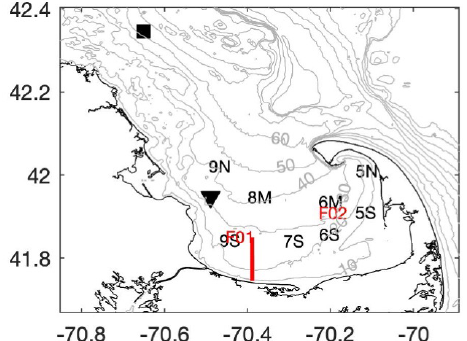
Figure 1. Map of Cape Cod Bay (CCB) showing the locations of the CCS monthly water quality stations (black letters), the MWRA sampling locations in CCB (red letters), NDBC buoy 44013 (black square), MDMF Wreck of the Mars bottom temperature sensor (black triangle), and the 2020 transect shown in Fig. 3 (red line). Grey contours are depths in